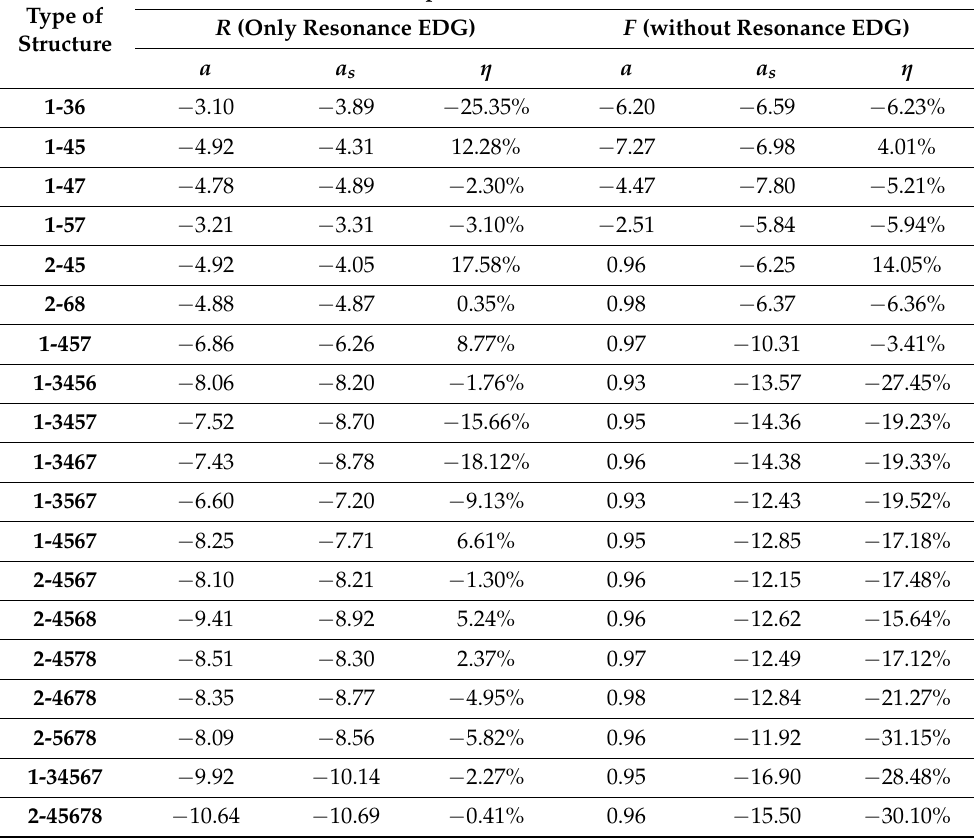
Table 6. Obtained values of the slope, a , and calculated values (assuming the perfect additivity) of a s and η (relative error of additivity) for poly(CF 3 )substituted naphthalene derivatives in dependence of SESE values on R and F